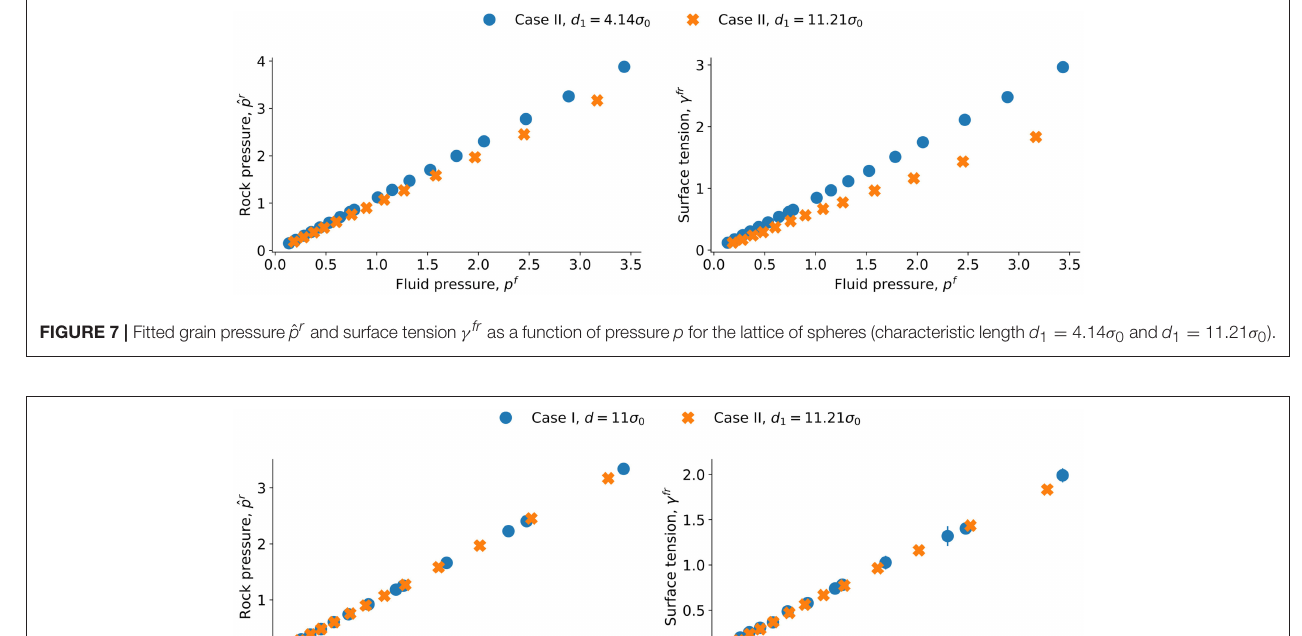
FIGURE 8 | Fitted grain pressure (characteristic length d 1